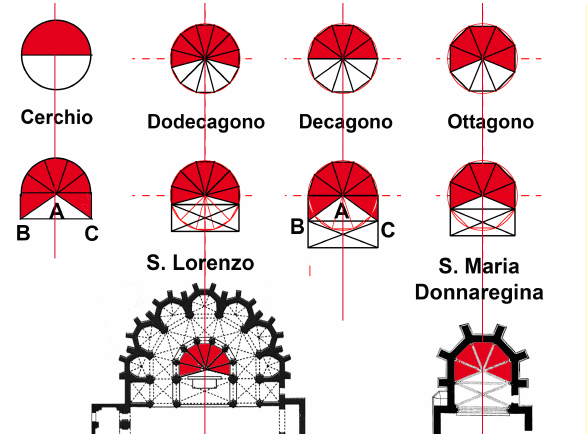
Figure 1 . Apse tracing: geometric rules for adaptive parametric